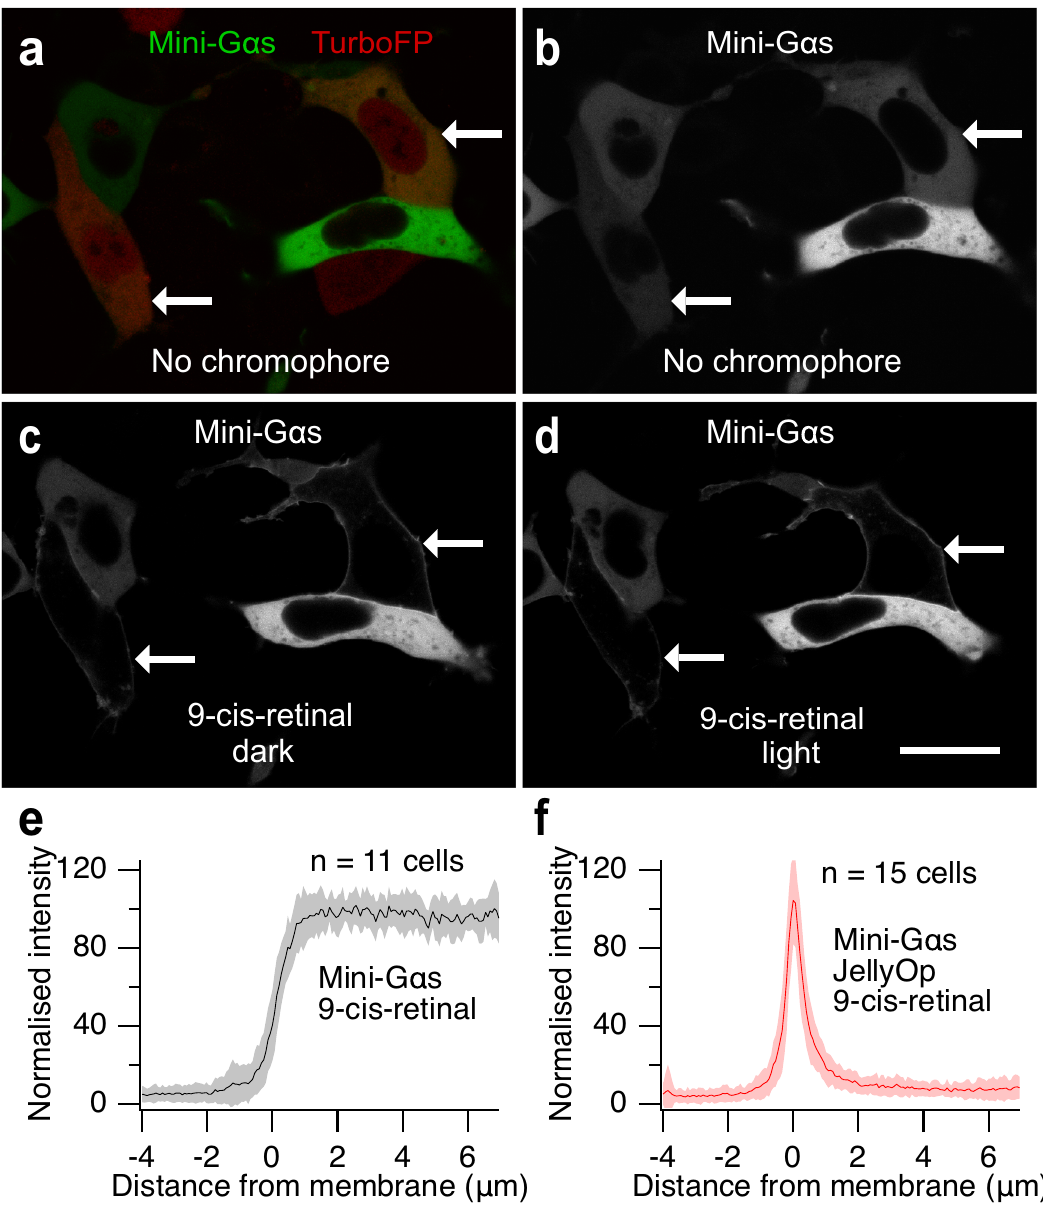
Fig. 2 | JellyOp recruits NES-venus-MiniG α s to the cell membrane. a A fi eld of HEK293 cells transiently transfected with NES-venus-MiniG α s (green) and JellyOp- IRES-TurboFP635 (red), with two cells that express both plasmids (arrows). b The green channel from ( a ) shows that NES-venus-MiniG α s is in the cytoplasm in the absenceofachromophore. c Afteradding9-cis-retinalinthedark(1 μ Mfor10min), NES-venus-MiniG α sisrecruitedtothecellmembrane,onlyinthecellsthatexpress